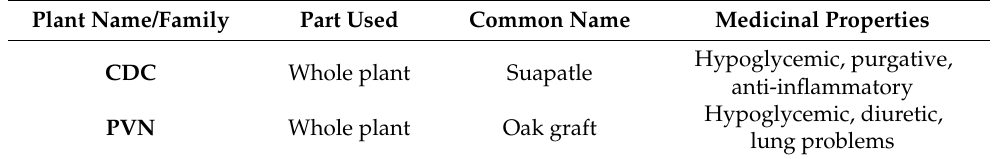
Table 3. Uses of selected plants in traditional medicine.